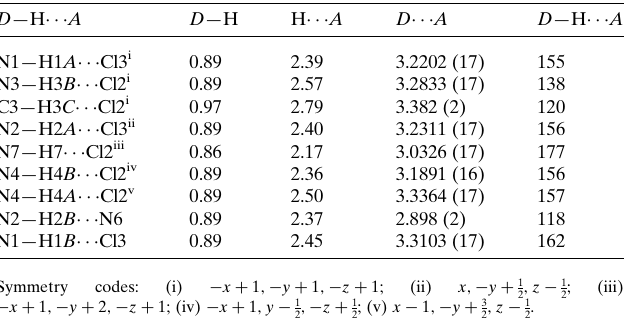
Table 1 Hydrogen-bond geometry (A˚ , (cid:4) ).